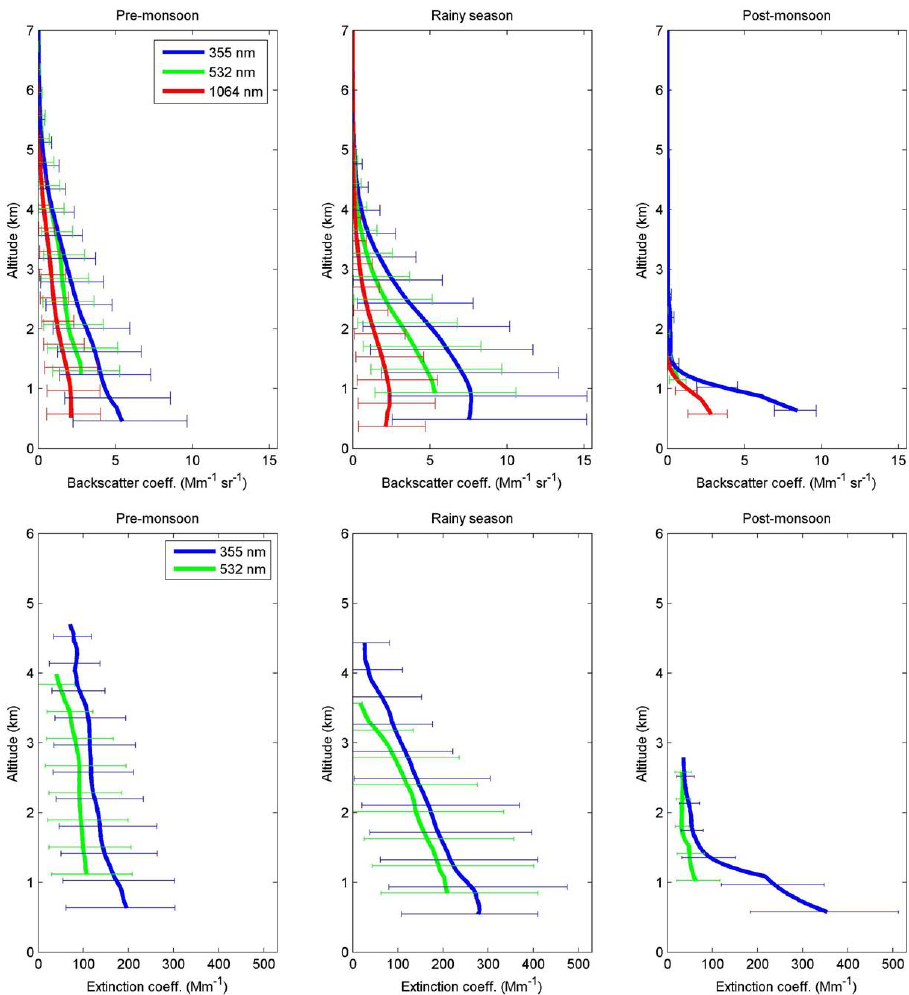
Fig. 11. Seasonal averaged backscatter and extinction profiles at two wavelengths for the Gual Pahari site during 2008. The 10 and 90 percentiles are also shown.